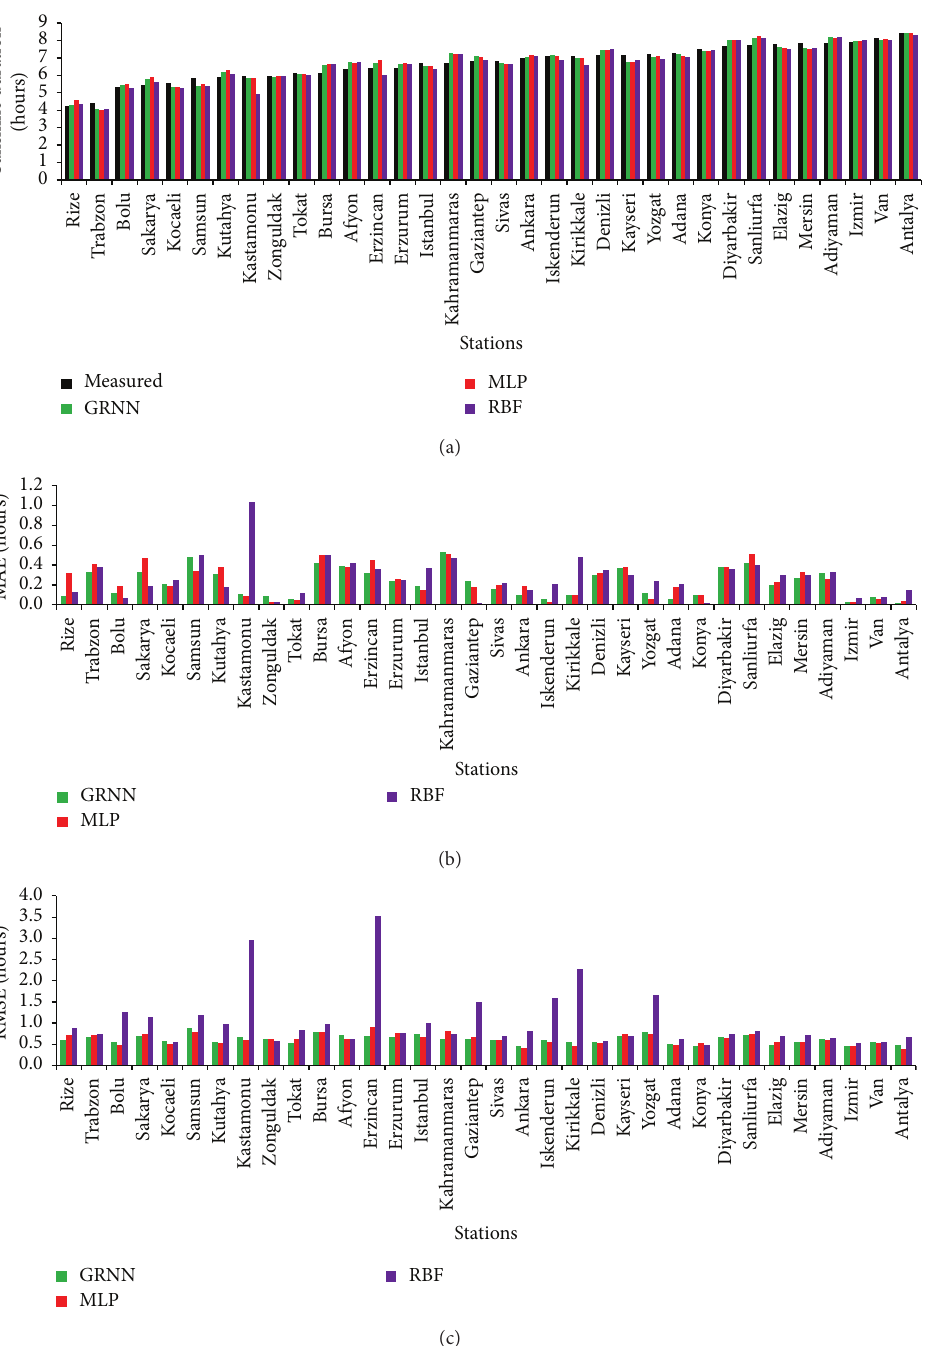
Figure 5: (a) Measured and estimated values of average monthly mean SD for each station from 2001 to 2006. (b) MAE for each station. (c) RMSE for each